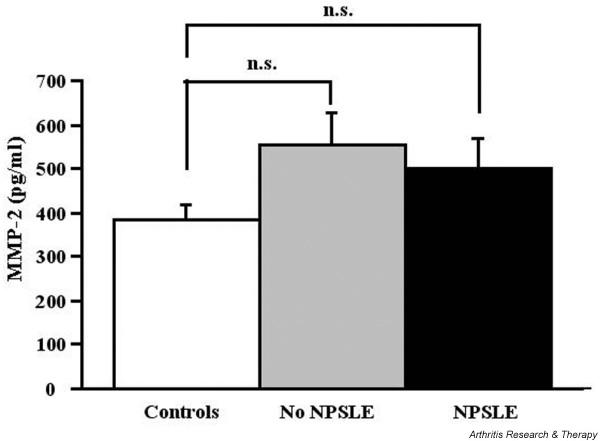
Cerebrospinal fluid expression of active matrix metalloproteinase (MMP)-2 in patients with systemic lupus erythematosus with (NPSLE) and without (No NPSLE) central nervous system involvement, and in cerebrally healthy control individuals.